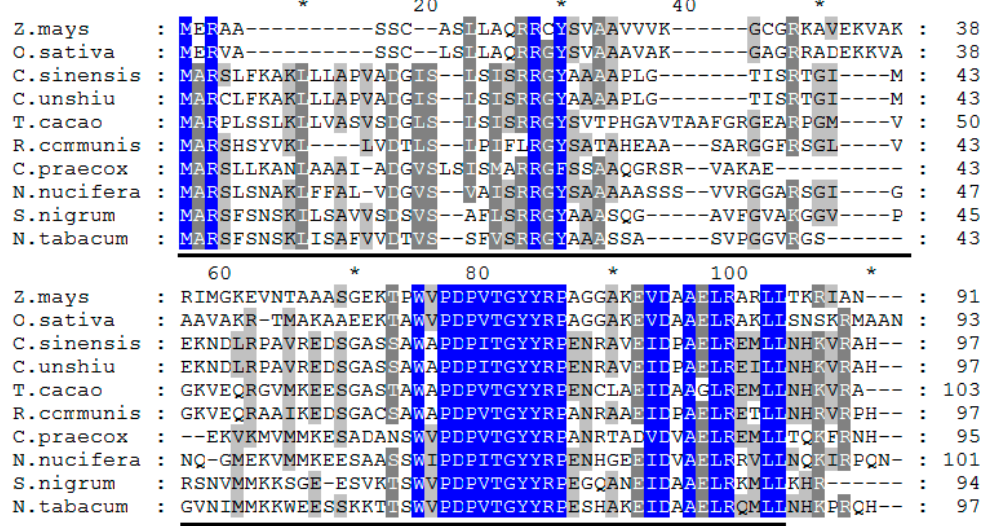
Figure 2. Multiple alignment of CpLEA5 and LEA5 from other species in NCBI. Identical residues are shown in blue, highly similar residues are shown in dark grey and similar residues are shown in light grey. The LEA_5 domain is underlined. * Represents the amino acid number increased by twenty from the 10th amino acid.